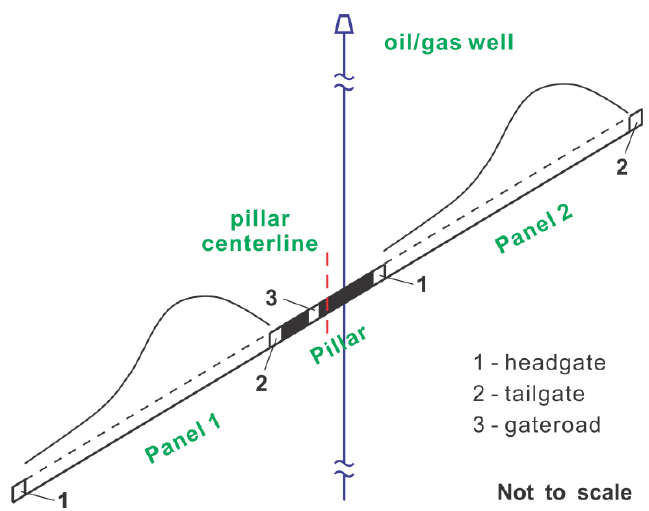
Figure 13. Schematic diagram of overburden failure range of longwall panels advance along strike of an inclined coal seam and the optimal location of the oil/gas well. After only the first panel is removed, peak horizontal shear offsets induced by removing the downdip panel are less than those induced by extracting the updip panel (Figure 12a). However, after the second panel is removed, shear offsets of well trajectories W2–W4 show somewhat complicated characteristics (Figure 12b). (1) For well trajectory W2, extraction of the updip panel prior to the downdip panel results in a smaller residual horizontal shear offset with increasing SDA; (2) Well trajectory W4 shows the opposite results; (3) For well trajectory W3, when SDA is less than 17°, extraction of the updip panel prior to the downdip side results in a smaller residual shear offset; however, when SDA is greater than 30°, the result reverses. A comprehensive analysis of the magnitude of horizontal shear offsets of well trajectories W2–W4 after the sequential extraction of panels flanking the pillar shows that shear deformation of wells induced by the extraction of only one panel dominates in general (horizontal shear offsets resulting from the removal of only one panel are larger than those resulting from the removal of both panels), irrespective of panel extraction sequence. Wells might have already suffered shear failure after the removal of only the first panel, especially when the updip panel is removed first. As a result, from the perspective of effective control of shear offsets of wells, extraction of the downdip panel prior to the updip side favors well integrity;